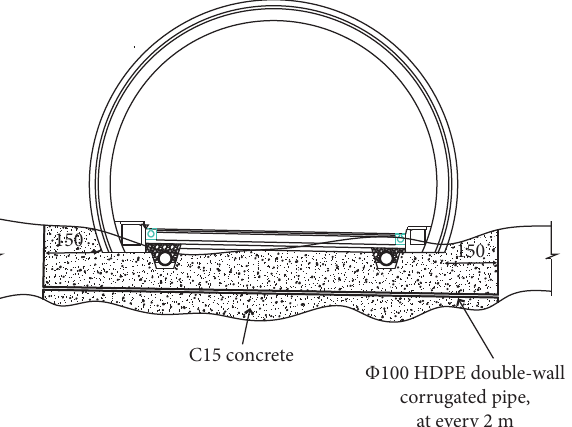
Figure 6: Small karst cavern at the sidewall.